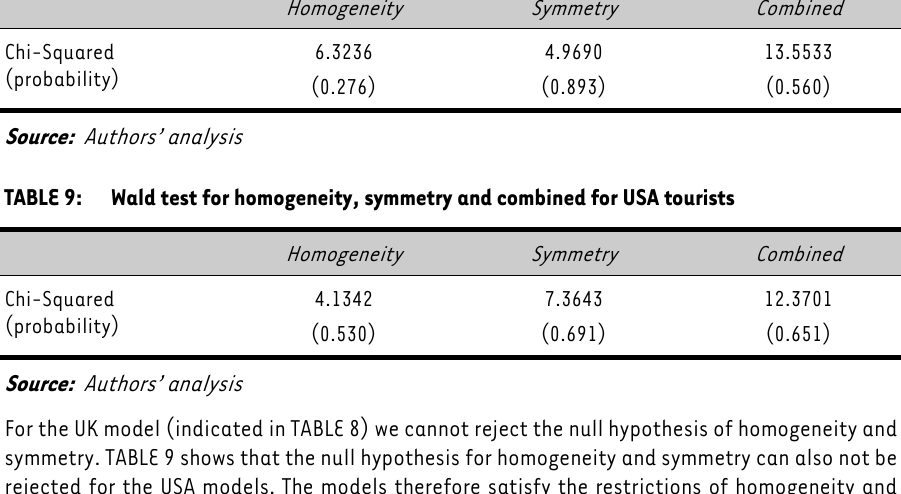
TABLE 8: Wald test for homogeneity, symmetry and combined for UK tourists Homogeneity Symmetry